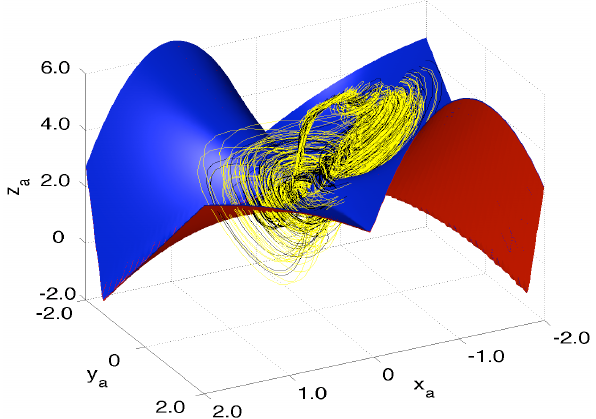
Fig. 7. Surface separating subset V 1 in phase space and its relative position to the fast subsystem attractor. The surface separates the V 1 region located above the blue side of the surface where all eigenval- ues have negative real parts (convergent), and the region below the red side of the surface corresponds to the region where uncertainties grow exponentially along divergent directions. Yellow lines show the trajectories of the fast model ensemble members and black the ensemble mean.